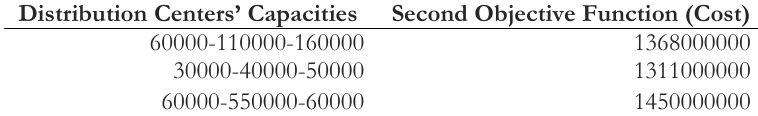
Table 12. Analysis of the effect of distribution centers’ capacities on the objec tive function of cost.